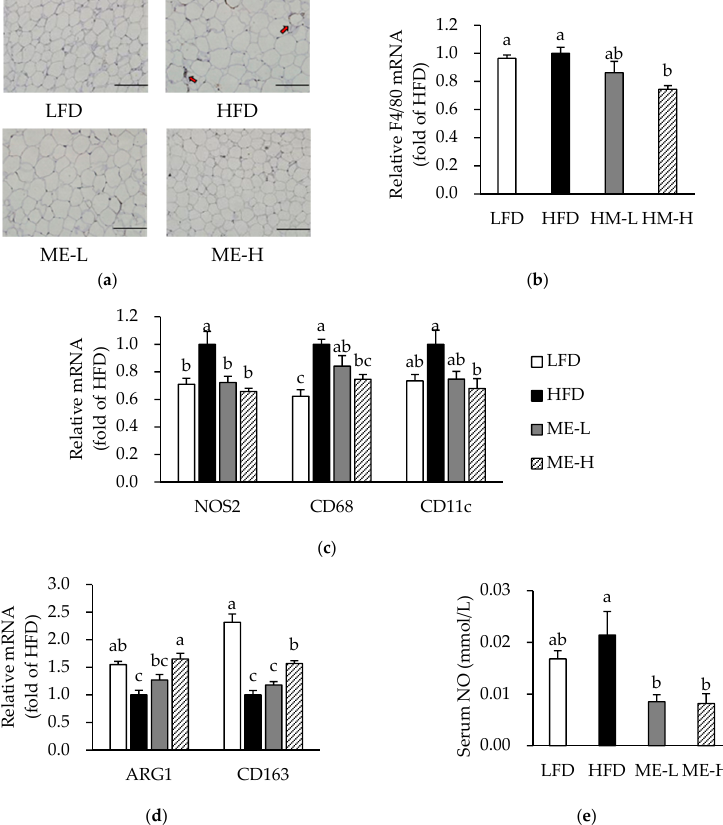
Figure 3. Effect of mulberry fruit extract on macrophage infiltration and M1/M2 type-switching in white adipose tissue. ( a ) Representative images of immunohistochemical staining for F4/80. Arrows indicate crown-like structures. Magnification of 200. Scale bars = 200 μ m. ( b ) F4/80 mRNA expression. ( c ) mRNA expression of genes specific for M1 macrophages. ( d ) mRNA expression of genes specific for M2 macrophages. The mRNA levels were normalized relative to the β -actin. ( e ) Serum NO level. Values are expressed as mean ± SEM (n = 8/group). Bars with different letters indicate a significant difference at p < 0.05. Abbreviations: LFD, low-fat diet; HFD, high-fat diet; ME-L, HFD + 5 g/kg diet of mulberry fruit extract; ME-H, HFD + 10 g/kg diet of mulberry fruit extract; NOS2, nitric oxide synthase 2; CD, cluster of differentiation; ARG1, arginase 1; and NO, nitric oxide.